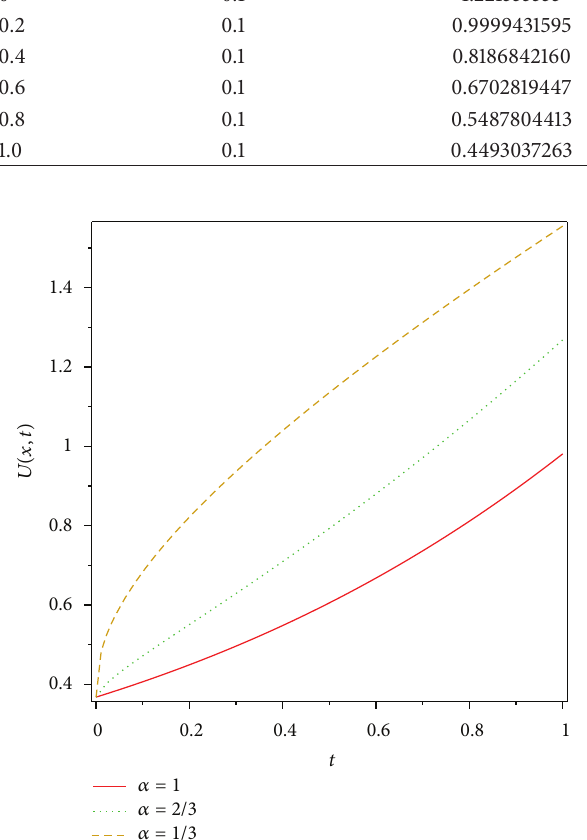
Figure 2: Plots of 𝑈(𝑥,𝑡) versus 𝑡 at 𝑥 = 1 for different values of 𝛼